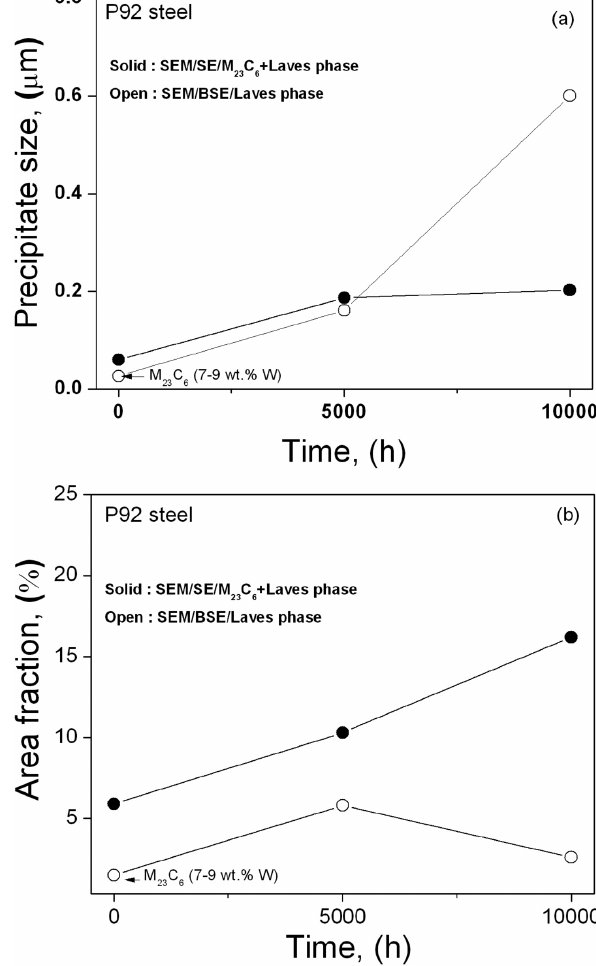
Figure 5: Variations of (a) precipitate size and (b) area fraction (%) of precipitates in the steel in normalized and tempered condition, thermal aged at 923 K for 5000 h and 10,000 h